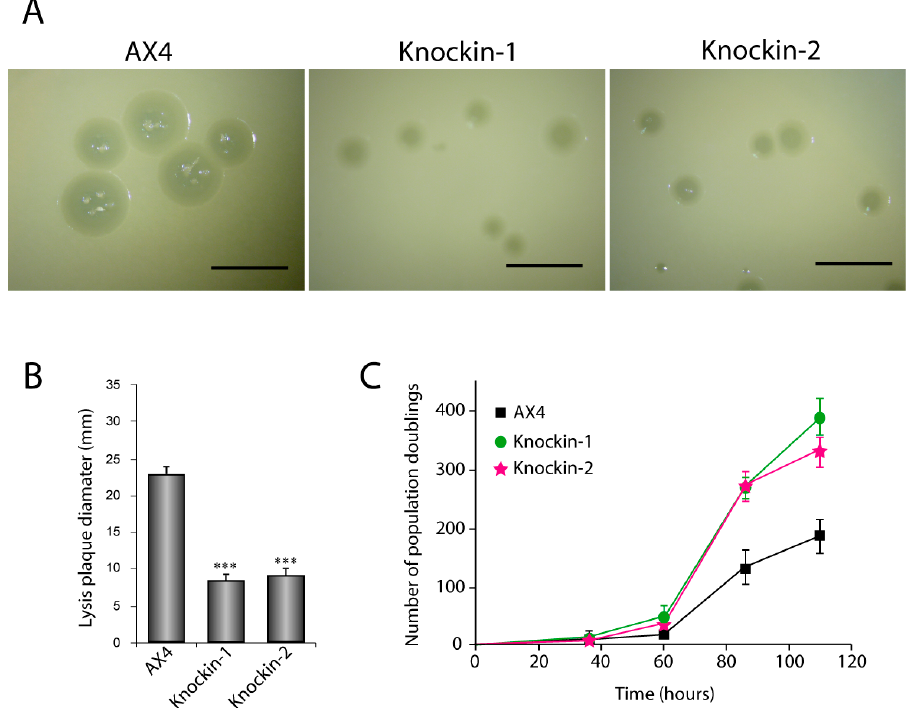
Figure 3. Proliferation capacity of dyskerin-mutated D. discoideum strains, D. discoideum AX4 cells were transfected with plasmids containing mutated dyskerin and cells that incorporated the mutations by homologous recombination selected. Knockin-1 strain incorporated the Ile38Thr and the knockin-2 strain de Thr49Met mutation. Wild-type and mutant strains were grown on bacteria for 5 days and the lyses plaques analyzed. ( A ) Panel A shows a picture of the plaques. Scale bar correspond to 5 mm. ( B ) Panel B shows a determination of the mean plaque diameter and the standard deviation determined after measuring 75 plaques from each strain. Statistical significance: *** p < 0.001. ( C ) Cell proliferation in liquid culture. 3 × 10 5 cells from each strain were cultured on axenic, liquid media. At the indicated times the number of cells was determined and the number of population doublings calculated. Mean values and standard deviations of three independent experiments are represented.